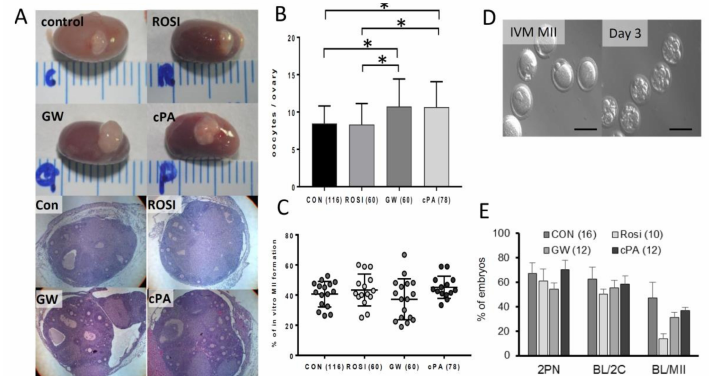
Figure 5. Ovarian histology showing follicle development after transplantation into kidney capsule. ( A ) Ovarian morphology 21 days after transplantation into the kidney capsule (upper) and HE staining (lower). ( B ) The number of oocytes per ovary from kidney transplantation and ( C ) the in vitro maturation (IVM) rate are shown. * indicates a significant di ff erence between groups, p < 0.05. The numbers in parentheses represent the total numbers of transplanted ovaries. ( D ) Mature oocytes from IVM, 3-day-old embryos after intracytoplasmic sperm injection (ICSI), Scale bar = 100 µ m, and ( E ) embryonic development after